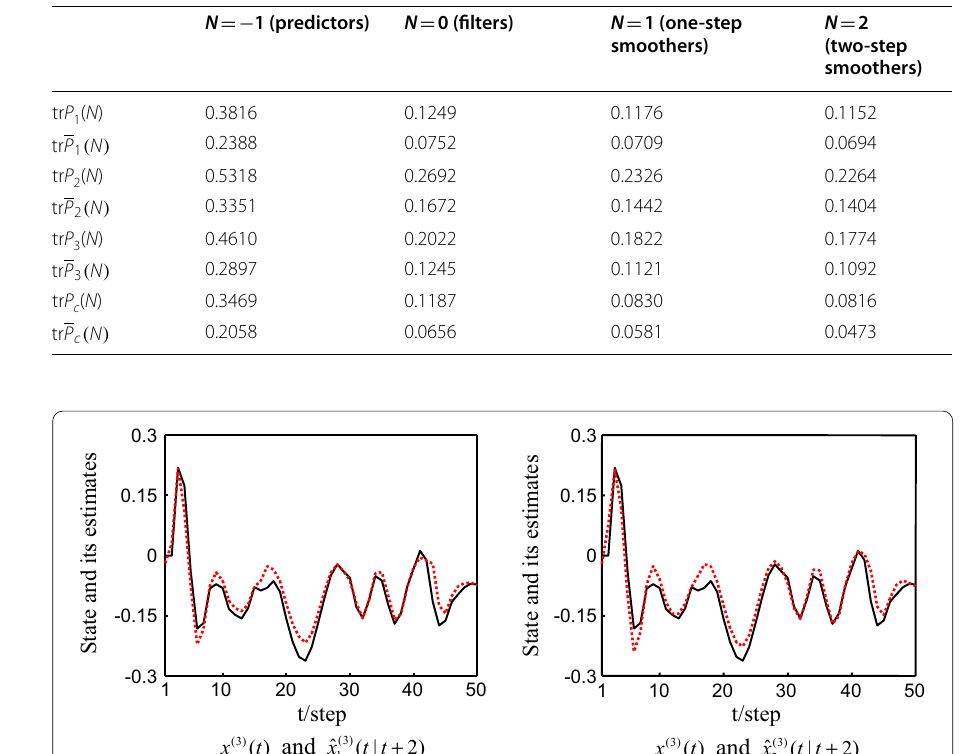
Table 1 Comparison of actual and robust accuracies